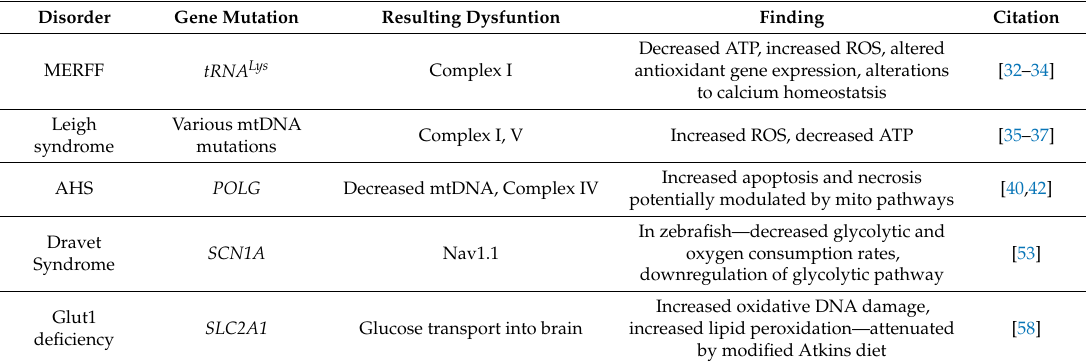
Table 1. Select studies implicating oxidative stress and metabolic dysfunction in select epilepsies associated with a genetic